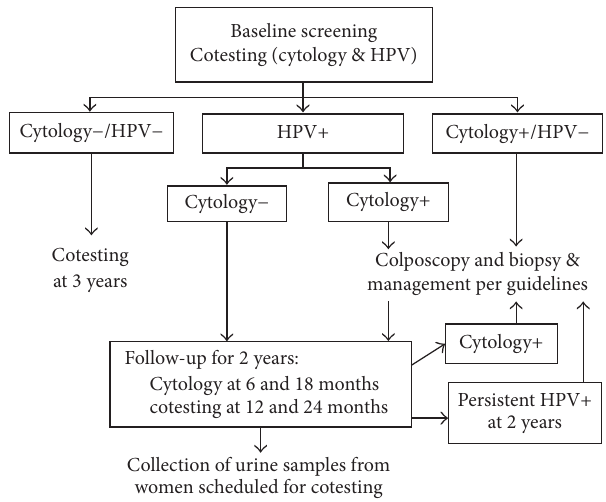
Figure 1: A flowchart describing the study